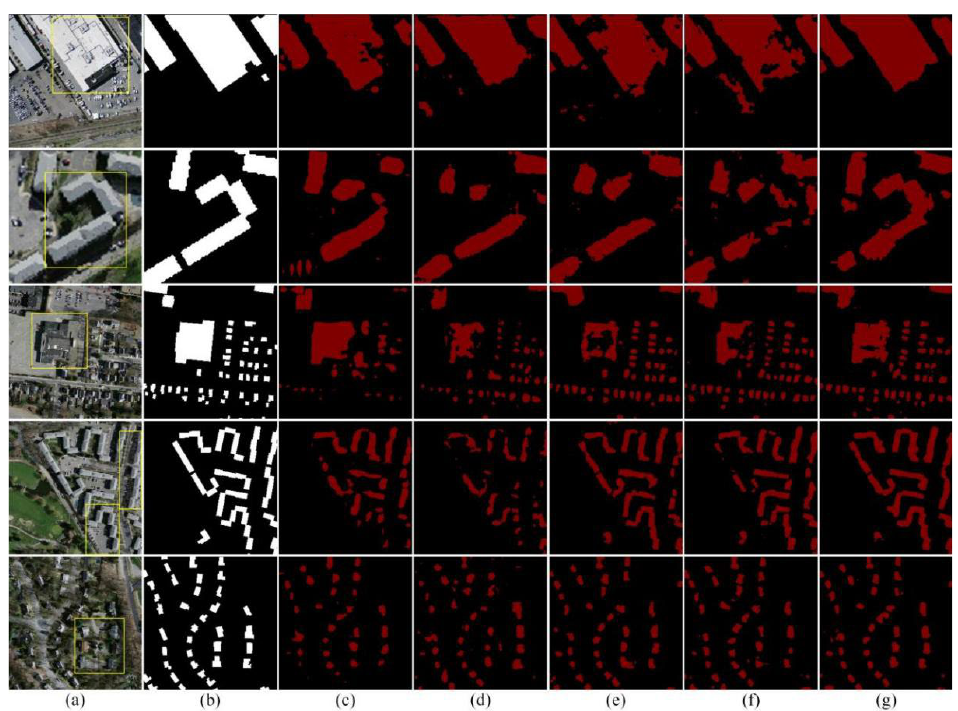
Figure 6. Typical building extraction results on the WBD. ( a ) Images. ( b ) Labels. ( c ) DeepLabv2. ( d ) PSPNet. ( e ) UNet. ( f ) TransUNet. ( g ) TRANet. Yellow boxes identify partial differences between the different methods.